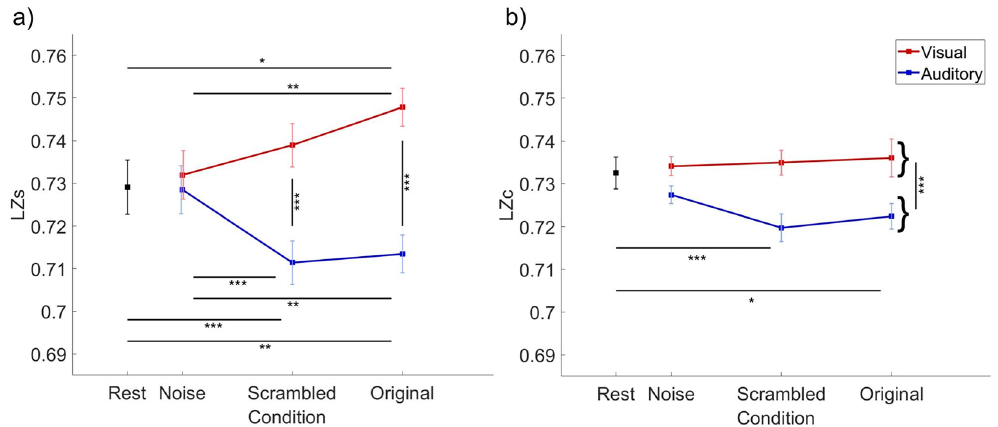
Figure 1. Mean values of ( a ) temporal (LZs) and ( b ) spatio-temporal (LZc) diversity scores observed during the resting state and visual or auditory perception of stimuli varying in meaningfulness (original, scrambled, and noise versions). Error bars represent 95% of the confidence interval. Between-subject variability was removed from error bars 42 . Statistical significance of ANOVA post-hoc comparisons: *p < 0.05; **p < 0.01; ***p <